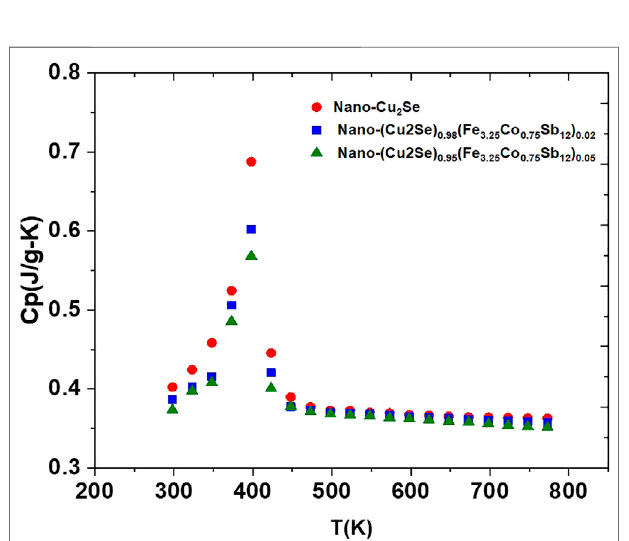
FIGURE 10 | Electronic part of thermal conductivity for nano-Cu 2 Se